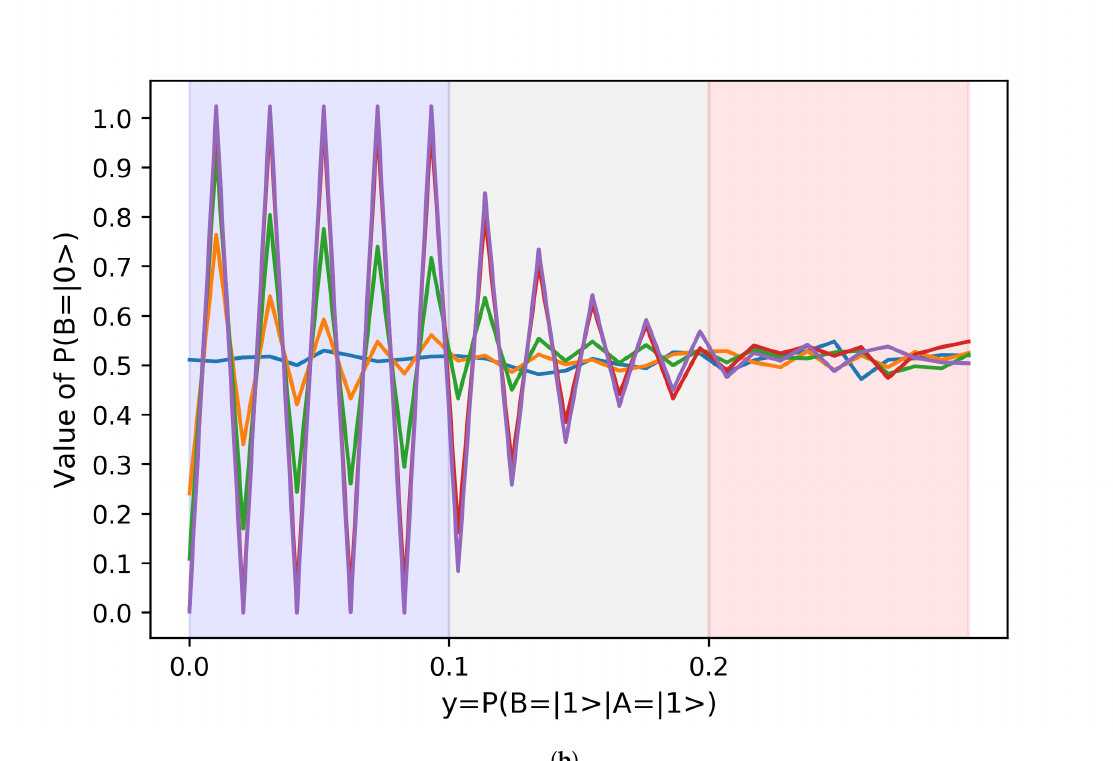
) . ( a ) Summary of results of P ( B = 0 | (cid:105)